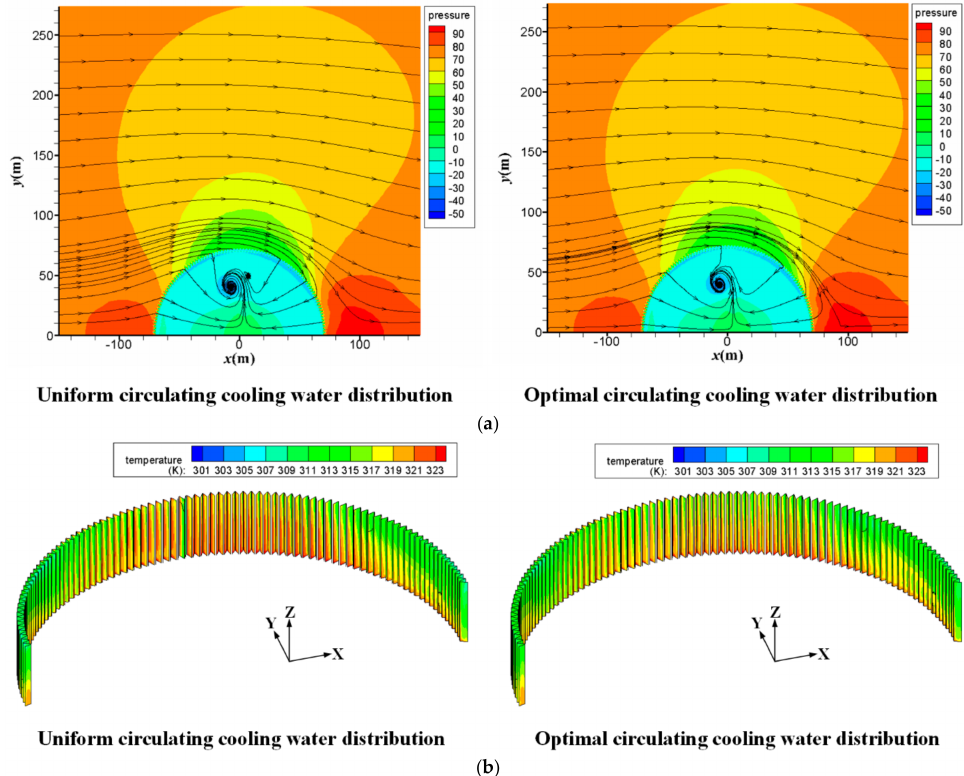
Figure 10. Variable fields under ambient temperature 24 ◦ C and crosswind speed 6 m s − 1 : ( a ) pressure fields and air streamlines at the height of 10 m and ( b ) air temperature fields of cooling